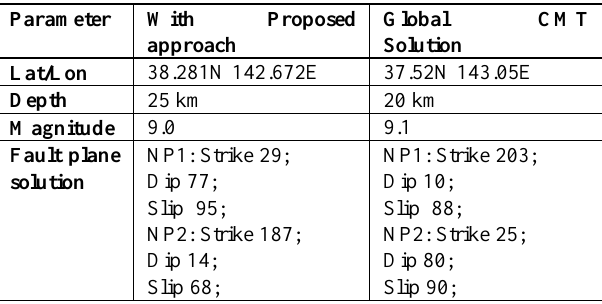
Table 1: Comparison of new approach and Global CMT